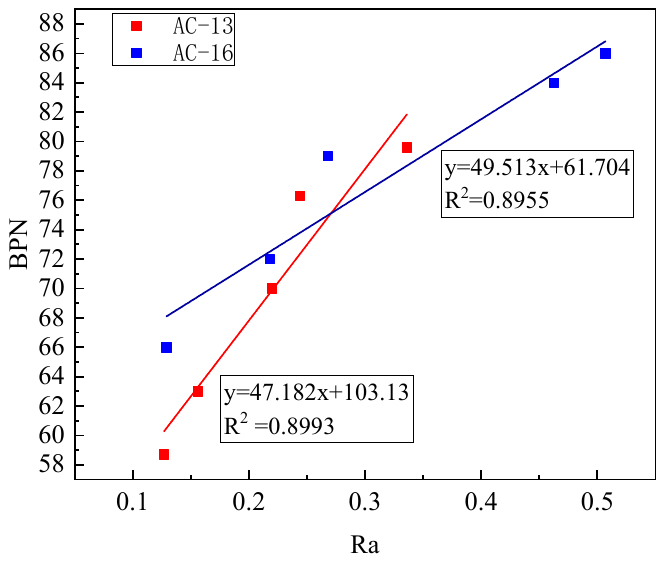
Figure 14. Relationship between BPN and Ra.